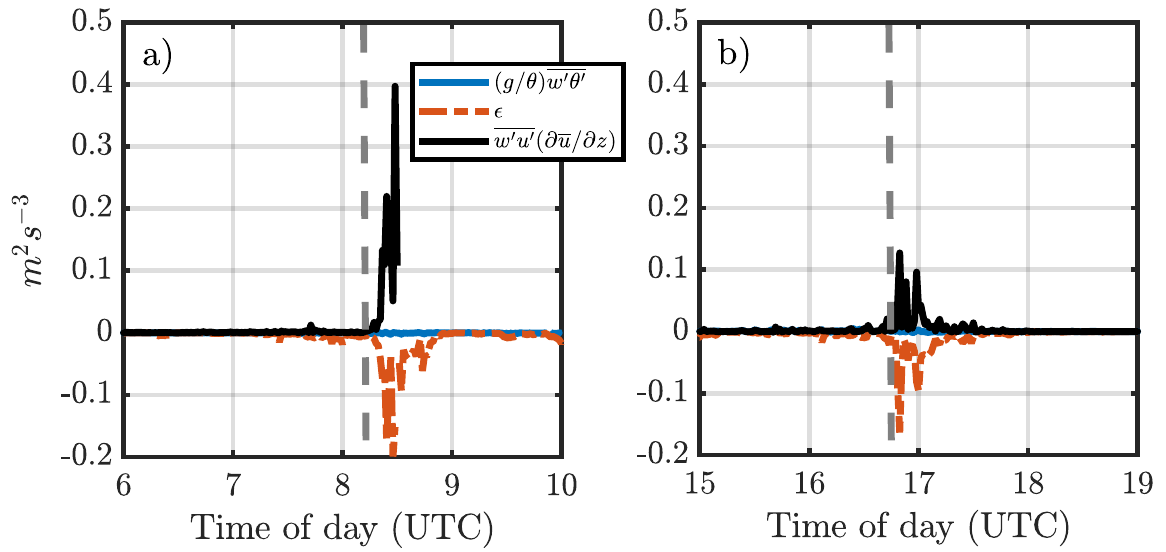
Figure 9. Estimates of thermal (blue line), mechanical (black line), and dissipation (red dashed line) terms of the turbulent kinetic energy (TKE)’s budget calculated at the highest measuring level of site T0k during passage: ( a ) of branch 1 and ( b ) branch 2 of a squall line at 21 April